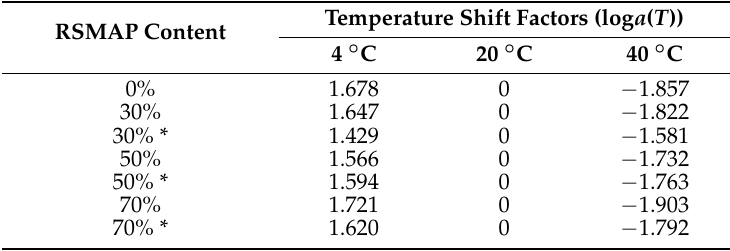
Table 13. Temperature shift factors (log a ( T )) of recycled mixtures. Table 13 Temperature shift factors (log a ( T )) of recycled mixtures.